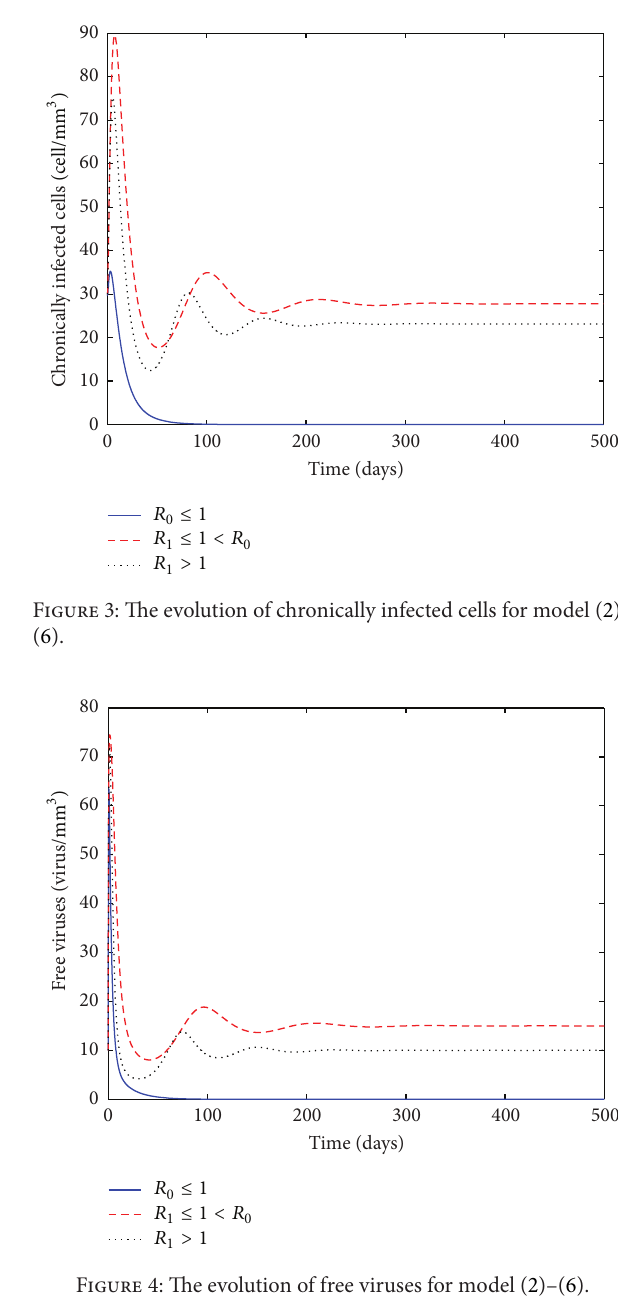
Figure 4: The evolution of free viruses for model